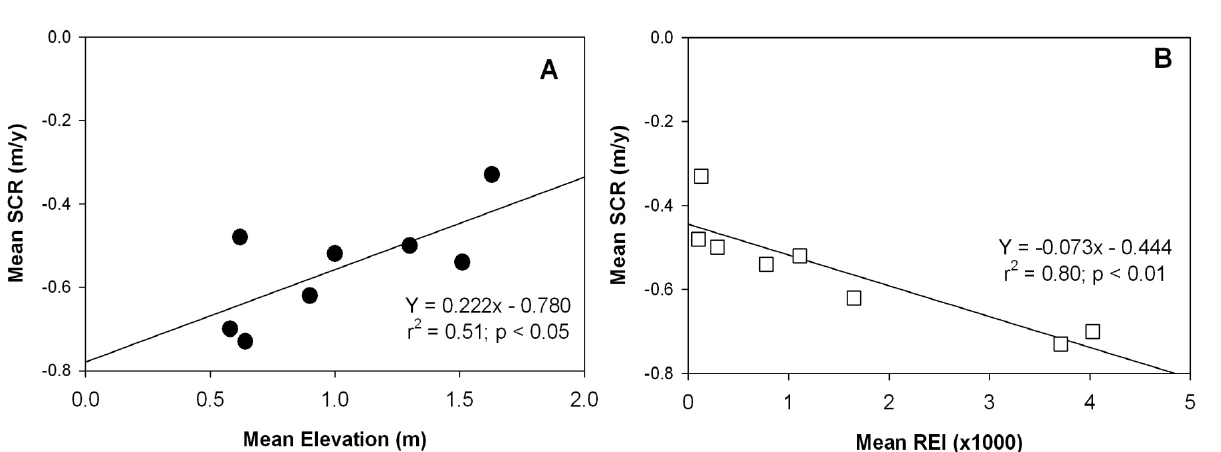
Figure 6. Scatterplots and linear regression of shoreline-change rate and ( A ) mean elevation, ( B ) mean relative exposure index, and ( C ) mean fetch values of the eight Local